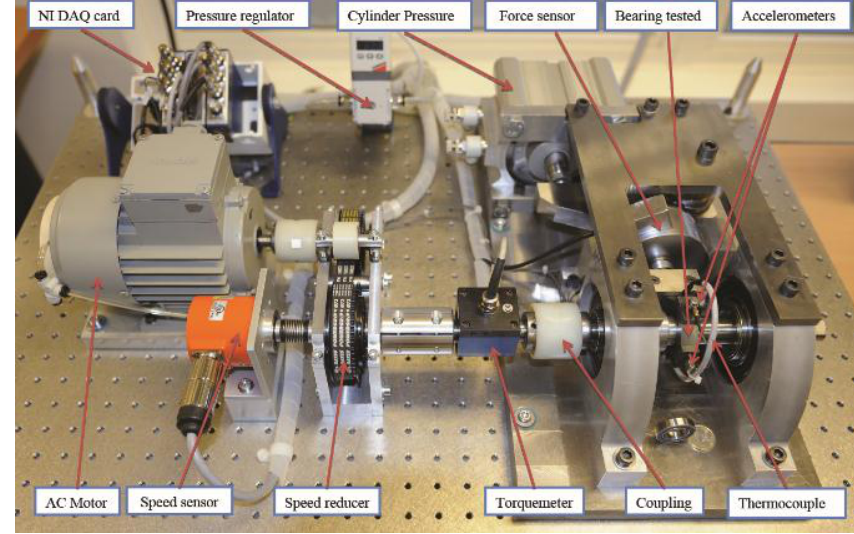
Figure 4. Overview of PRONOSTIA [31] experimental platform.